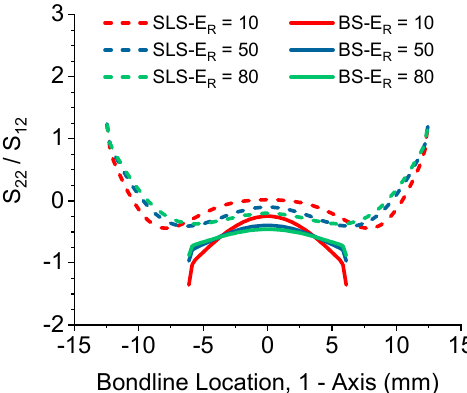
Figure 12. Comparison of the ratio of peel stress to shear stress for single-lap shear (SLS) and block shear (BS) geometries along the bondline.